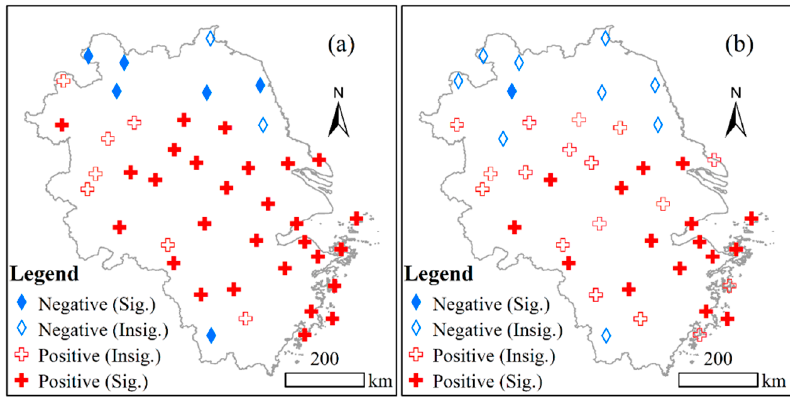
Figure 3. Spatial patterns of change trends calculated by MK ( a ) and MMK ( b ).